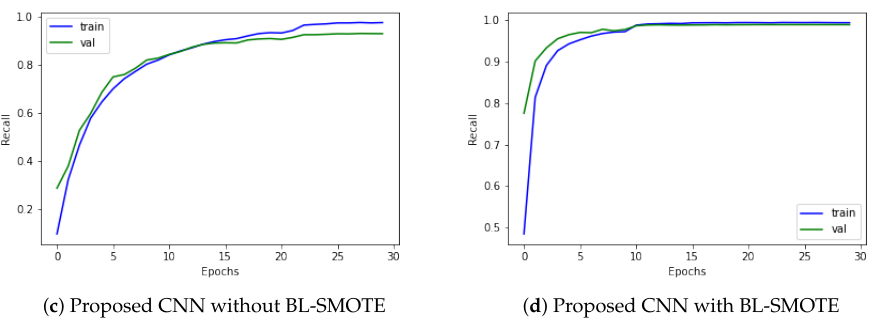
Figure 10. The recall analysis to provide an overview of the sensitivity between the actual positive and the positive predictive value for ( a ) VGG16, ( b ) Efficient-Net B0, and ( c , d ) DAD-Net with and without up-sampling.